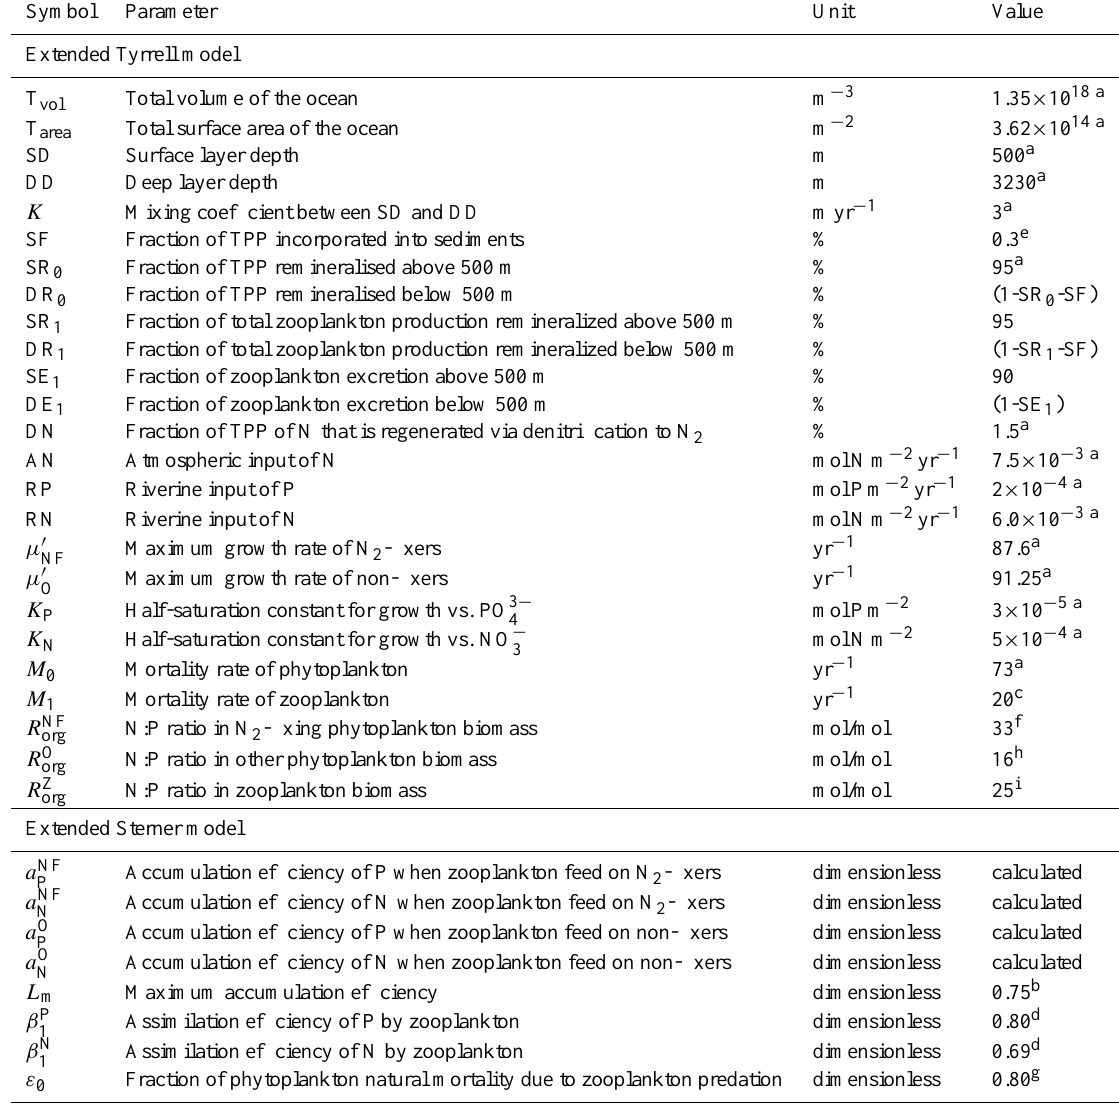
Table 1. Definitions of model parameters, values and literature sources. Symbol Parameter